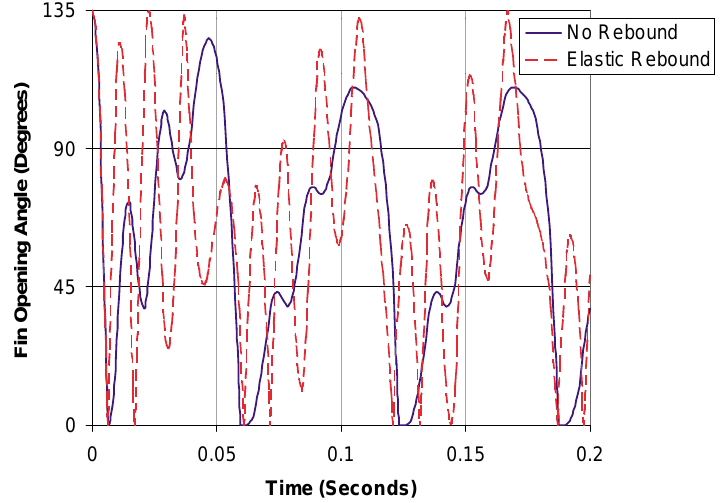
Fig. 16. Fin angle response to Impact with Fin Stop as a function of time, no locking mechanism, 5 degrees of yaw, 15.6 Hz spin